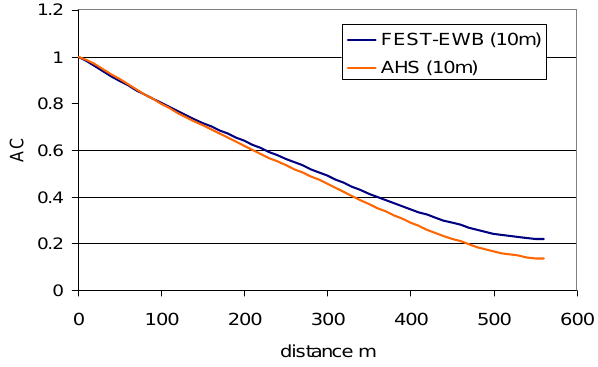
Fig. 9. Comparison between autocorrelation functions of LST from MODIS, FEST-EWB and AHS at the spatial resolution of